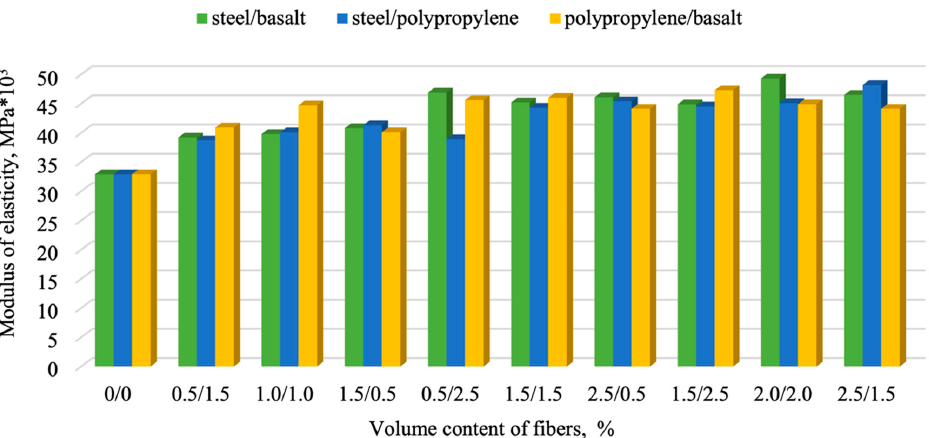
Figure 10. Dependence of ultimate deformations of fiber-reinforced concrete under axial tension on the type of fiber combination and volume content.